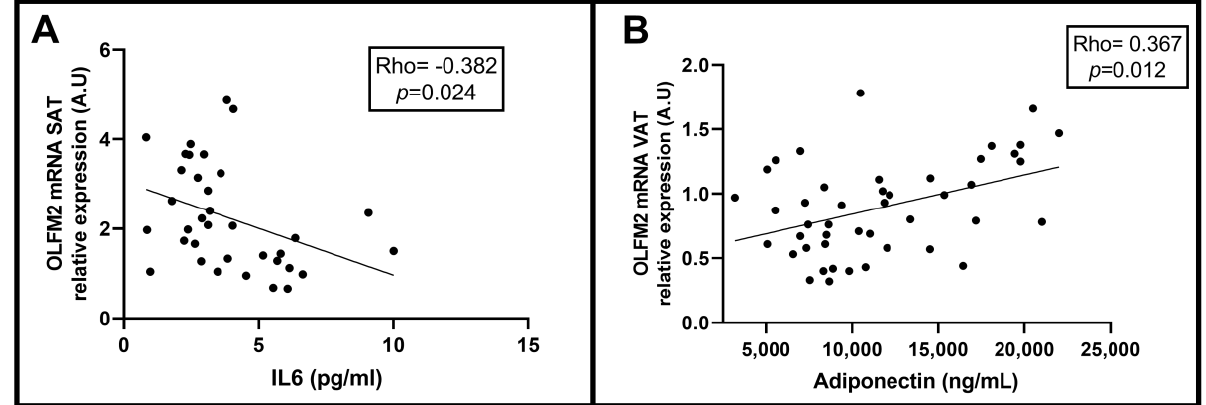
Figure 6. ( A ) Significant negative correlations between OLFM2 mRNA expression in SAT and circulating levels of IL-6. ( B ) Significant positive associations between OLFM2 mRNA expression in VAT and adiponectin levels. OLFM, olfactomedin; IL, interleukin; SAT, subcutaneous adipose tissue; VAT, visceral adipose tissue; A.U, arbitrary units. The Spearman test was used to calculate the correlation coefficient (rho), and p < 0.05 was considered statistically significant.